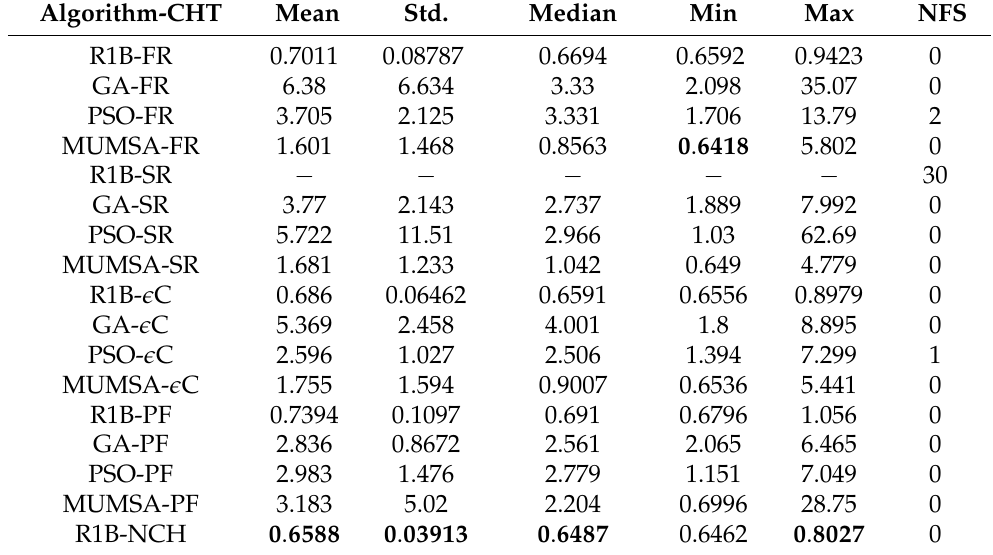
Table 8. Descriptive statistics of the obtained results for each metaheuristic algorithm in study case 2 with trajectory